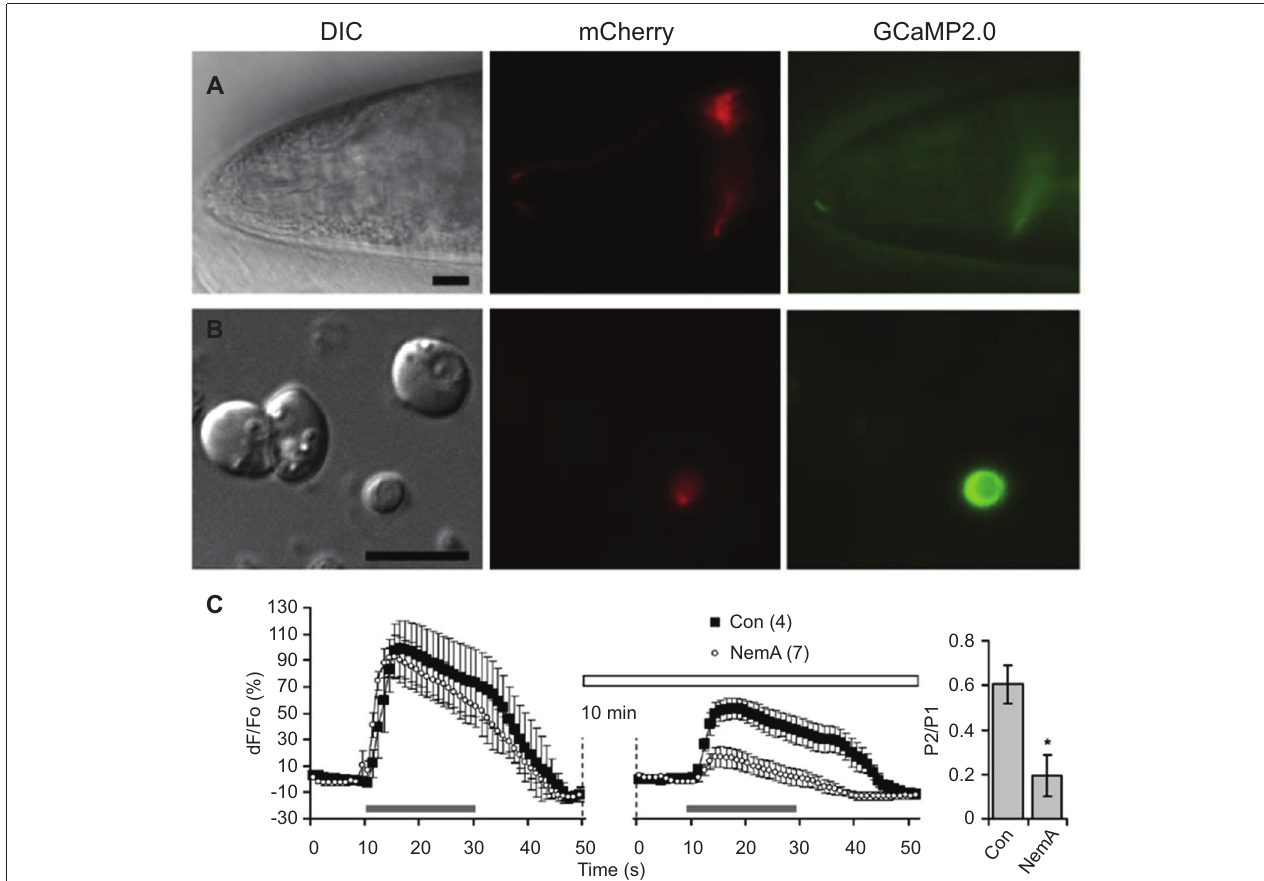
CEPsh glial cells. Paired-pulse application of a depolarization stimulus, high extracellular potassium (HiK + , 100 mM; horizontal grey bar) to CEPsh glial cells results in an elevation of intracellular Ca 2 + levels (black squares). Nemadipine-A (NemA), a pharmacological L-type VGCC blocker, can be used to test the channels present in glial cells in culture (horizontal open bar); Con, sham stimulated control (right, bar graph). Ratio of the peak Ca 2 + level in response to the second HiK + application (P2) over the first application (P1). * Indicates a significant difference. Adapted from Stout and Parpura